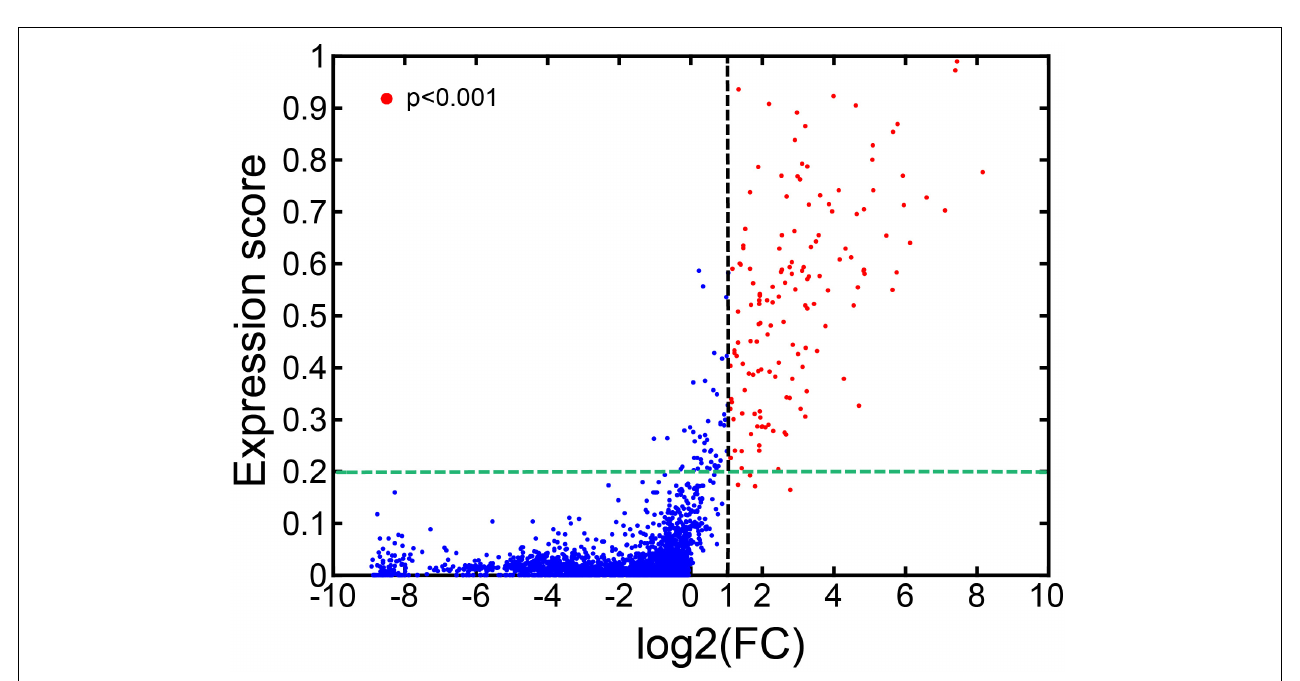
FIGURE 8 | Expression scores and log2( FC ) values of the CTS gene clusters in 101 cell types.